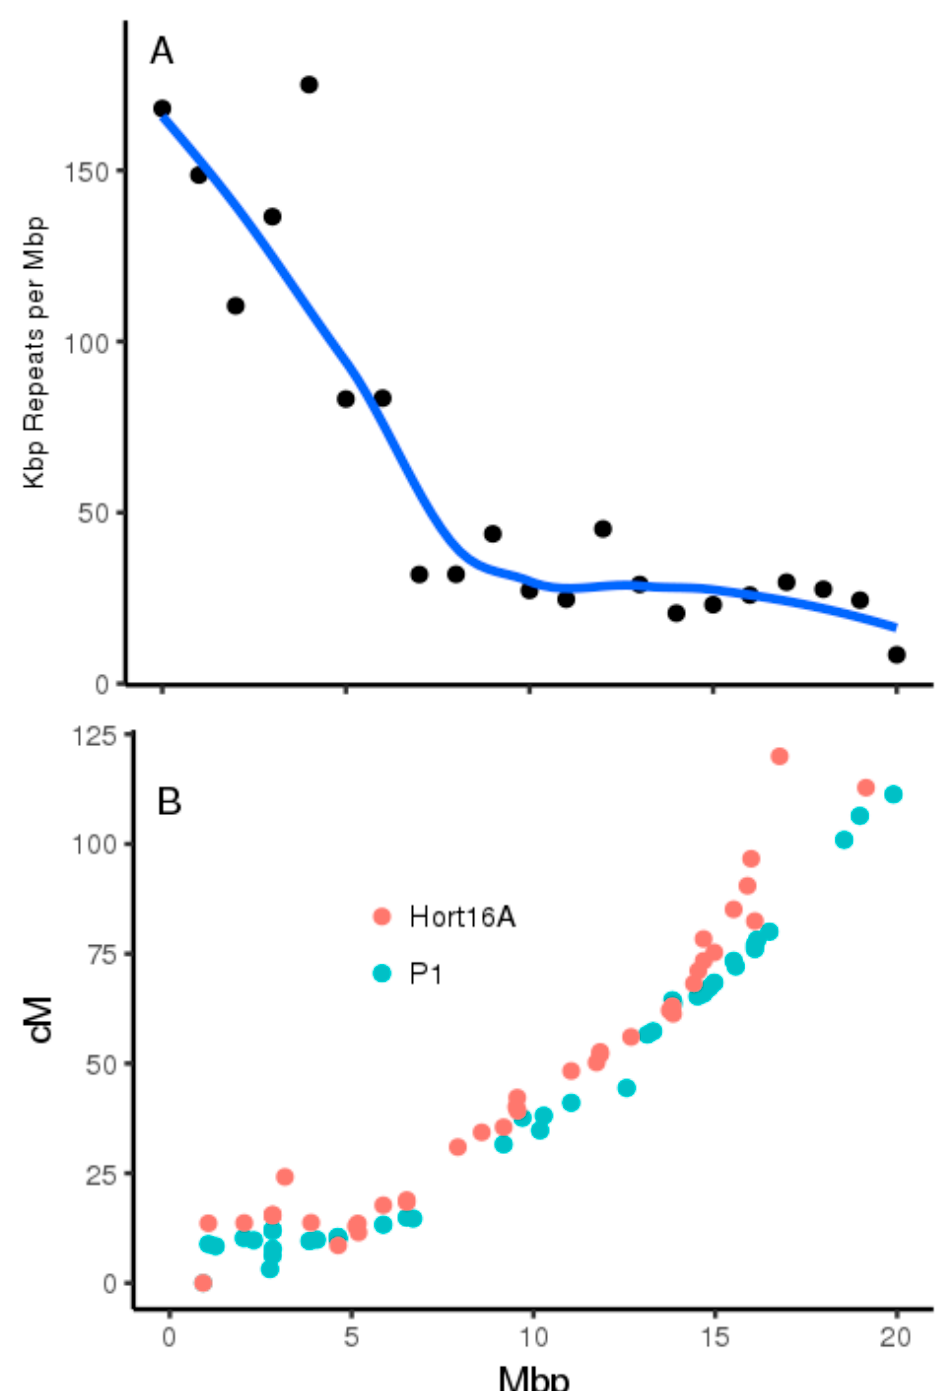
Figure 7. Composition and recombinational landscape of A. chinensis chromosome 26. ( A ) Total repeat annotations based on the ‘Red5’ assembly [4] ( B ) Physical versus recombination distance on A. chinensis ‘Red5’ Chromosome 26 estimated in male (green) and female (red) parental maps in the ‘Hort 16A × P1’ family [15].